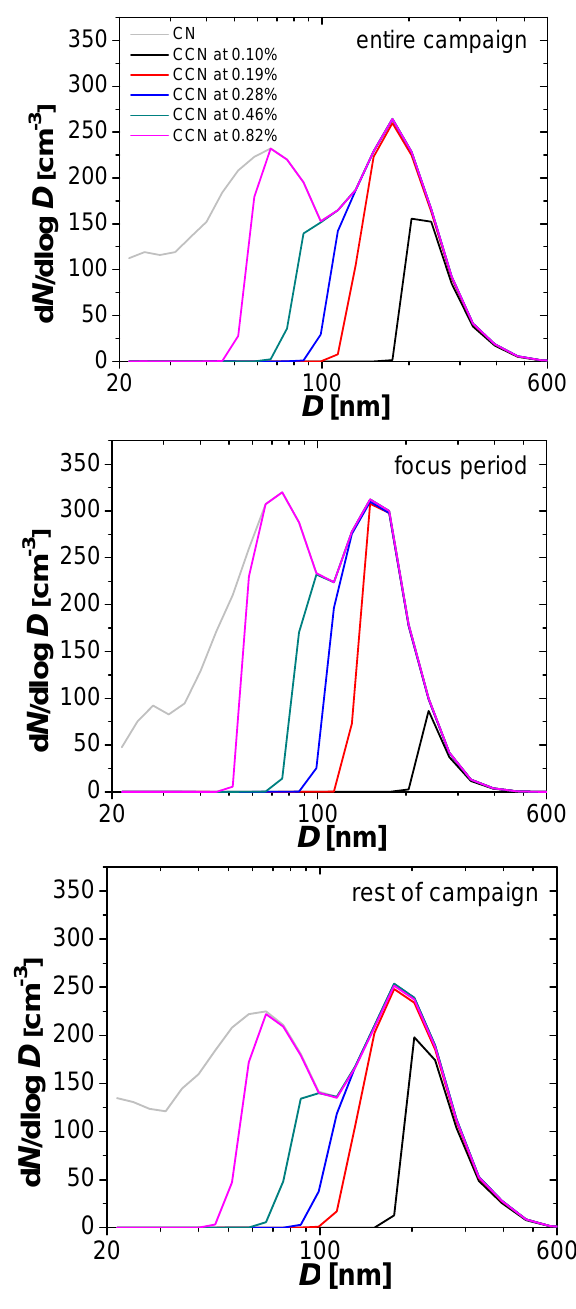
Fig. 6: Number size distributions of total aerosol particles (CN) and of cloud condensation nuclei (CCN) at different supersaturations ( S = 0.10-0.82%) averaged over the entire campaign (a), over the focus period (b), and over the rest of the campaign (c). The CCN size distributions were calculated by multiplying the median CN size distributions (grey lines) with median CCN efficiency spectra (3-parameter CDF fits).